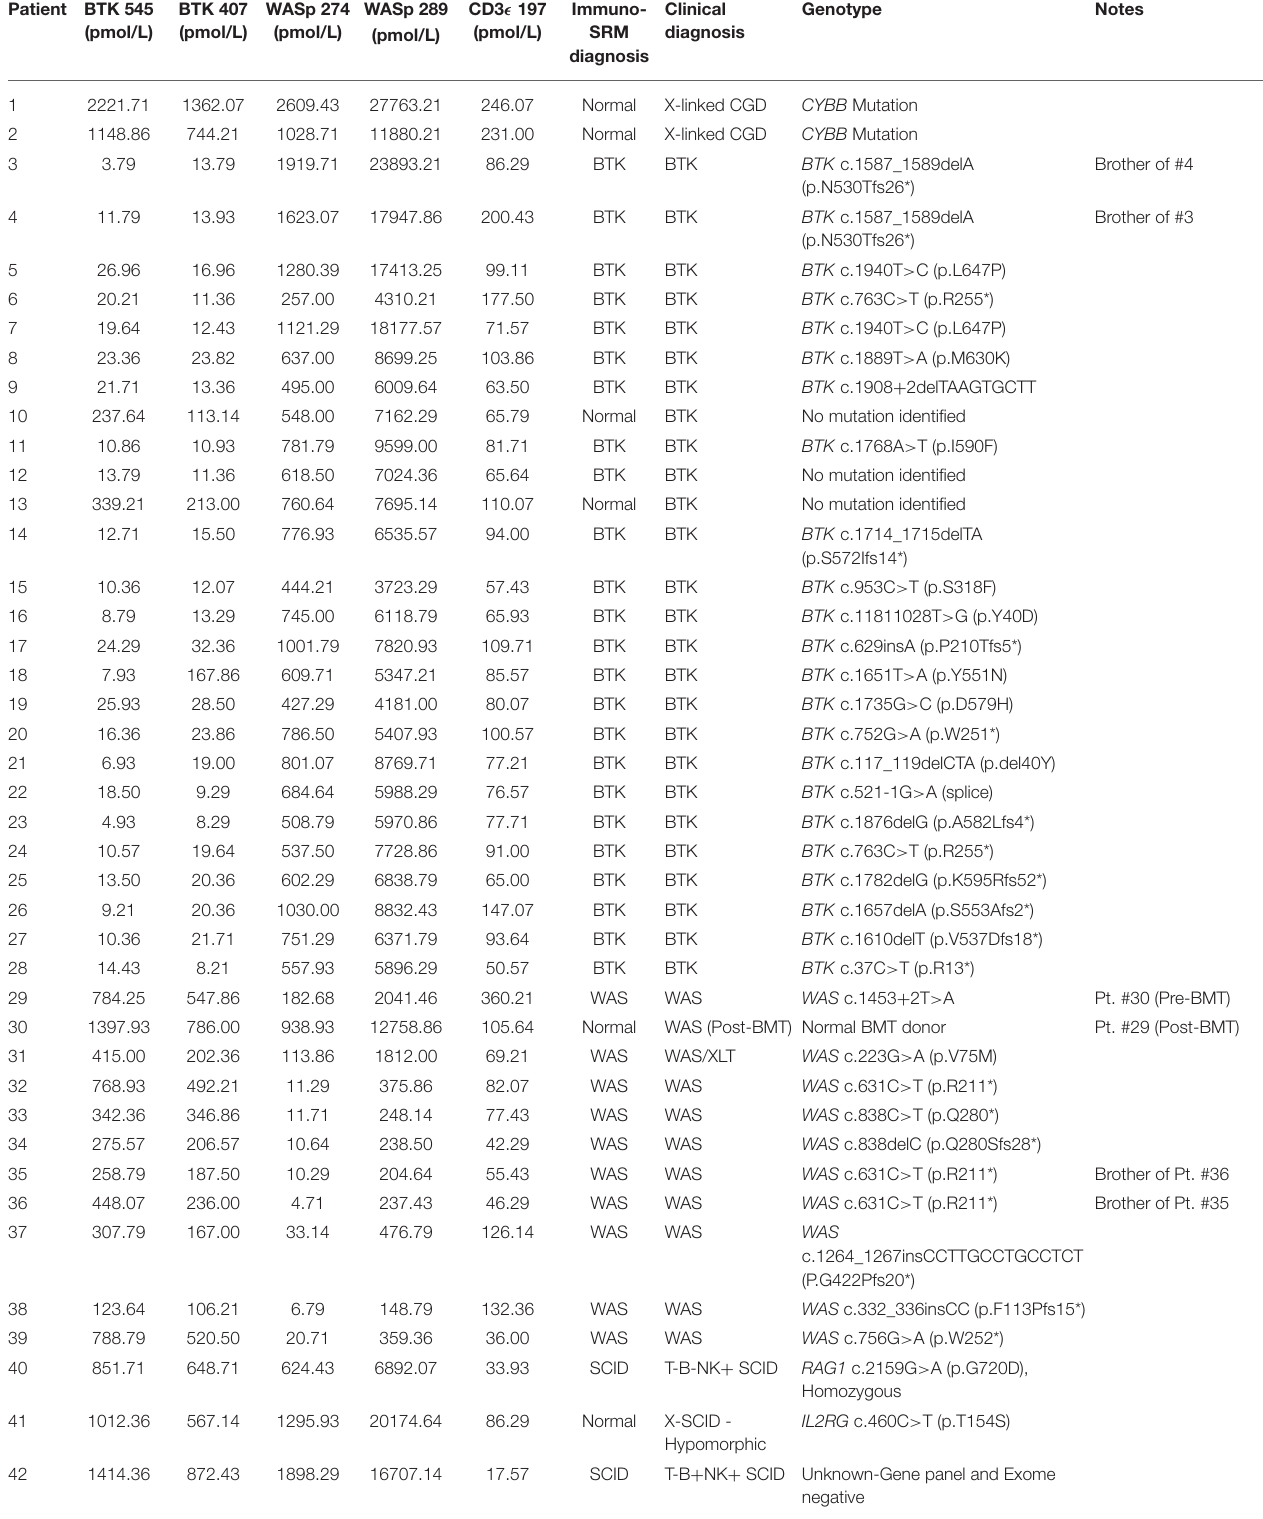
TABLE 4 | Concentrations of signature peptides in a blinded patient cohort study. Patient BTK 545